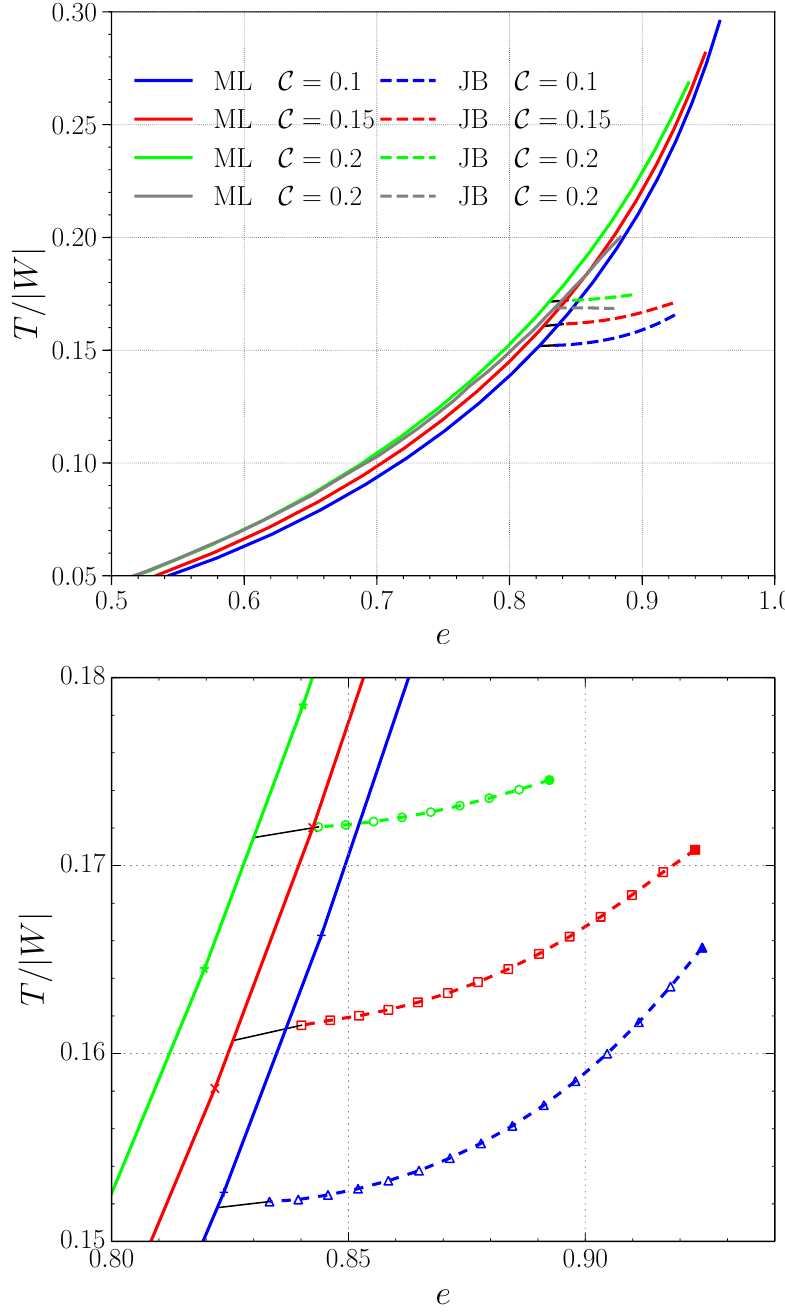
Figure 3. The same as Figure 2 but for the LX EoS